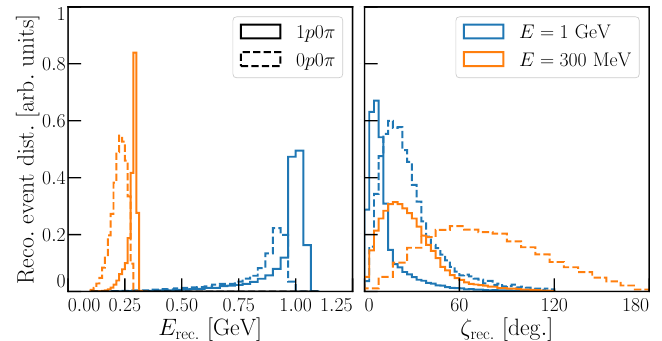
Figure 10 . One-dimensional distributions of reconstructed energy (left) and direction (right) for neutrinos with 1 GeV (blue) or 300 MeV (orange) energy. The solid (dashed) lines are for event samples with one (zero) visible final-state proton(s). See text for more